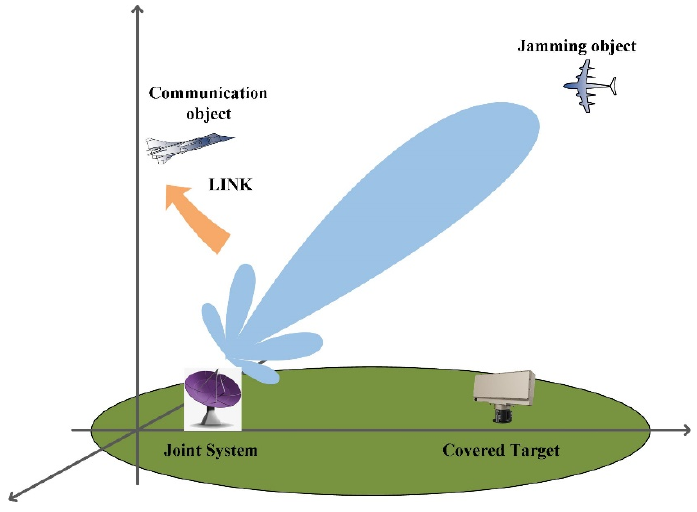
Figure 1. Application scenario of joint communication and jamming system.